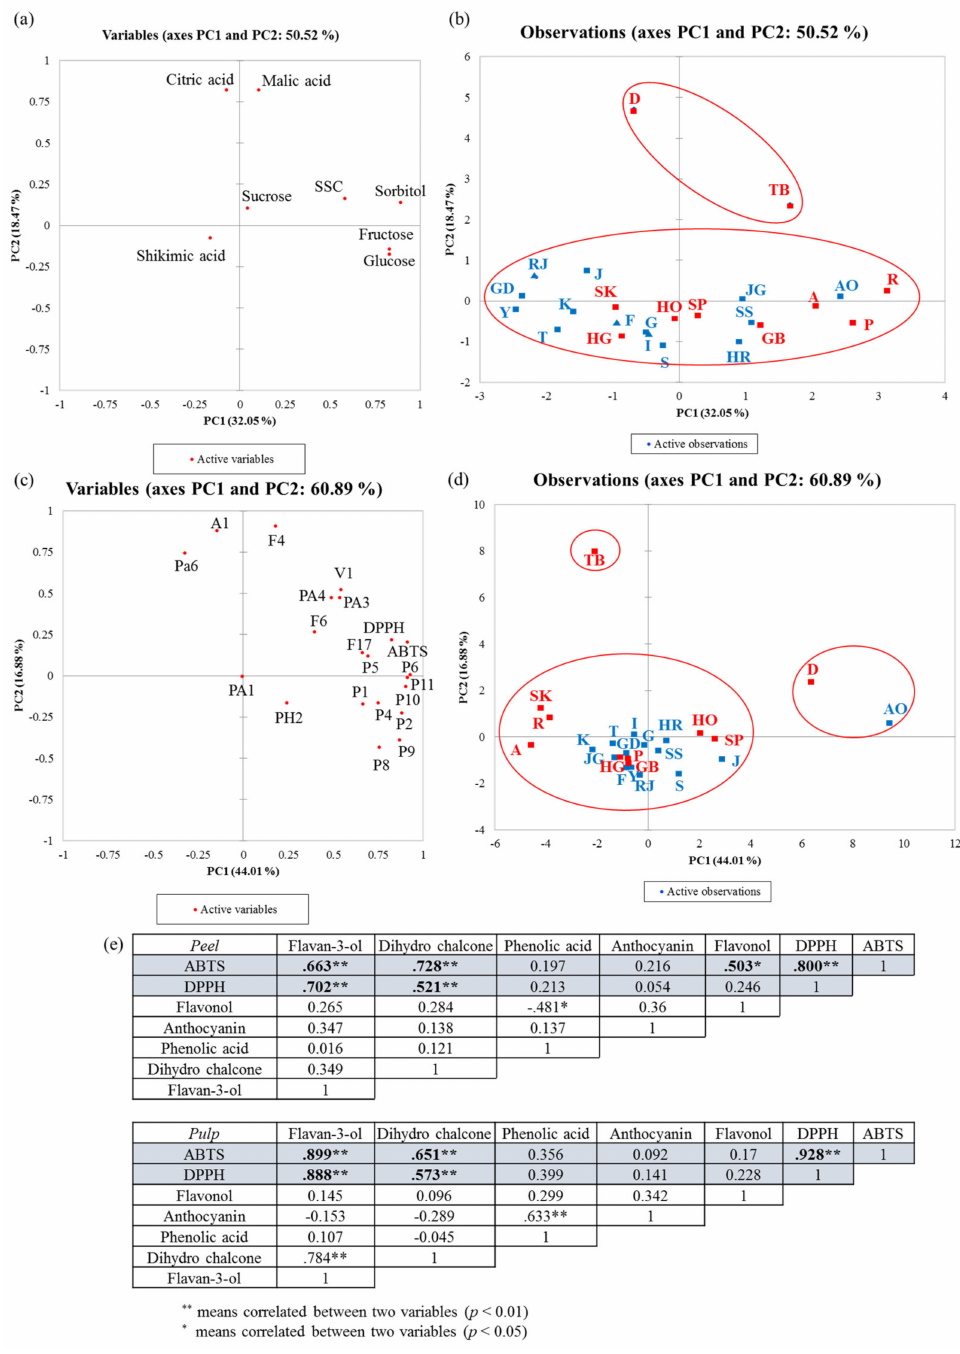
Figure 4. Principal component analysis of apple pulp: ( a ) PCA loading plot based on brix, organic acids, and free sugars, ( b ) PCA score plot based on brix, organic acids, and free sugars, ( c ) PCA loading plot based on phenolic compounds identified by UHPLC-(ESI)-qTOF, ( d ) PCA score plot based on phenolic compounds, ( e ) Pearson correlation matrix of results obtained from the apple samples (red and blue = new apple cultivars and traditional apple cultivars, respectively; rectangle and triangle = early- to mid-season). Sample codes for apple cultivars and compound codes correspond to those listed in Table 1 and Table S1,